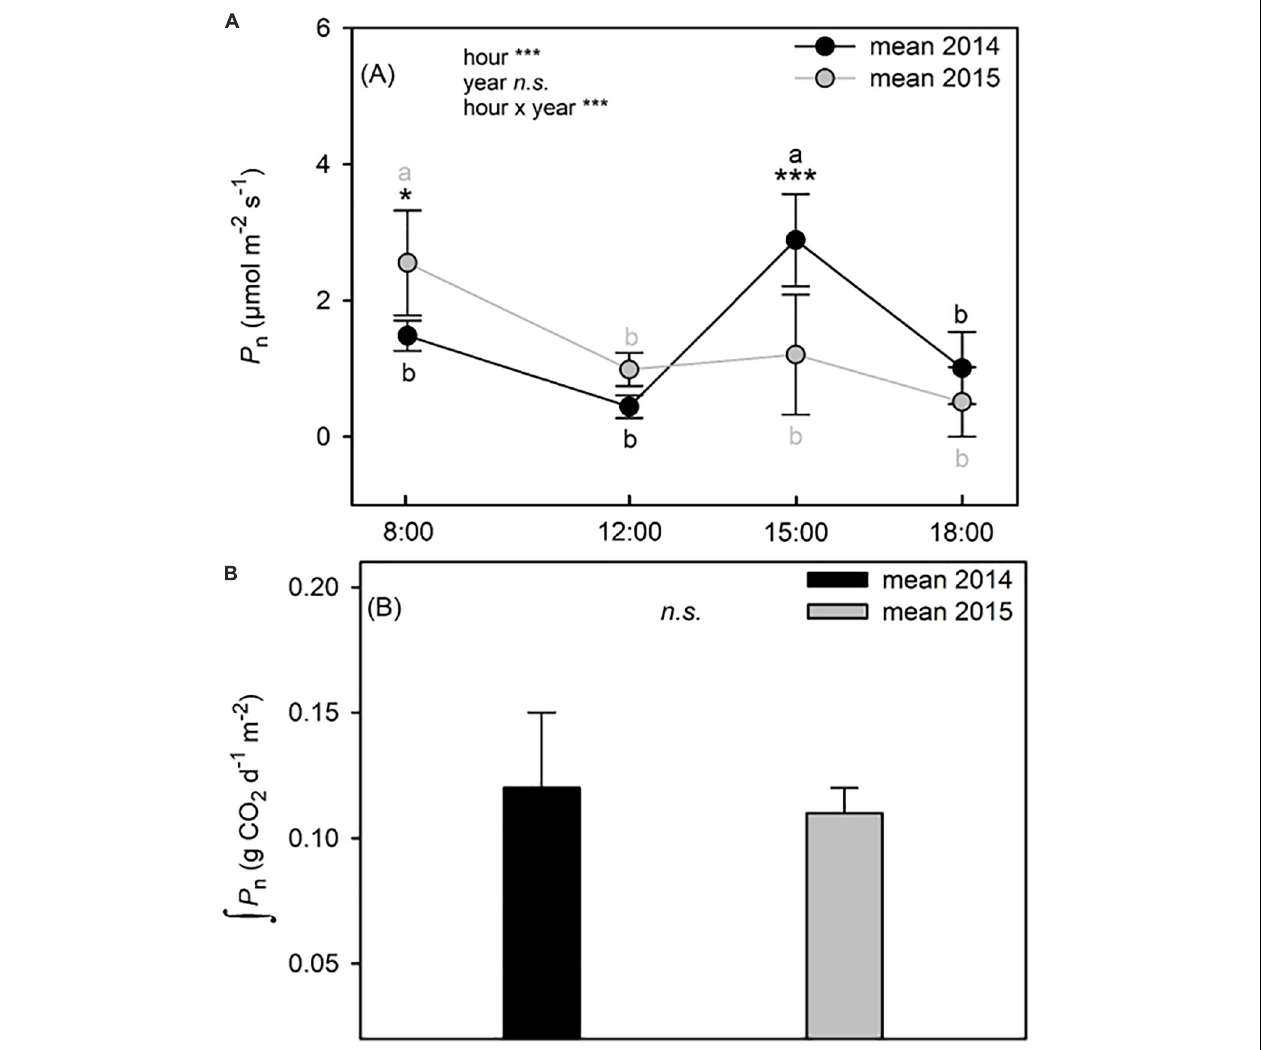
FIGURE 3 | Time course of net photosynthetic rate ( P n ) (A) and integration of daily net photosynthetic rate ( P n ) (B) of C. incanus leaves in July 2014 and 2015. Two way ANOVA followed by Tukey’s pairwise comparison was performed to compare data (means ± SD; n = 8) in (A) . Letters indicate significant differences ( p ≤ 0.05) among sampling hour for each year, whereas asterisks represent significant differences among years for each sampling hour, *( p ≤ 0.05), **( p ≤ 0.01), ***( p ≤ 0.001). The statistic adopted in panel B was a Student’s t -tests, asterisks represent differences between the two years, *( p ≤ 0.05), **( p ≤ 0.01), ***( p ≤ 0.001).